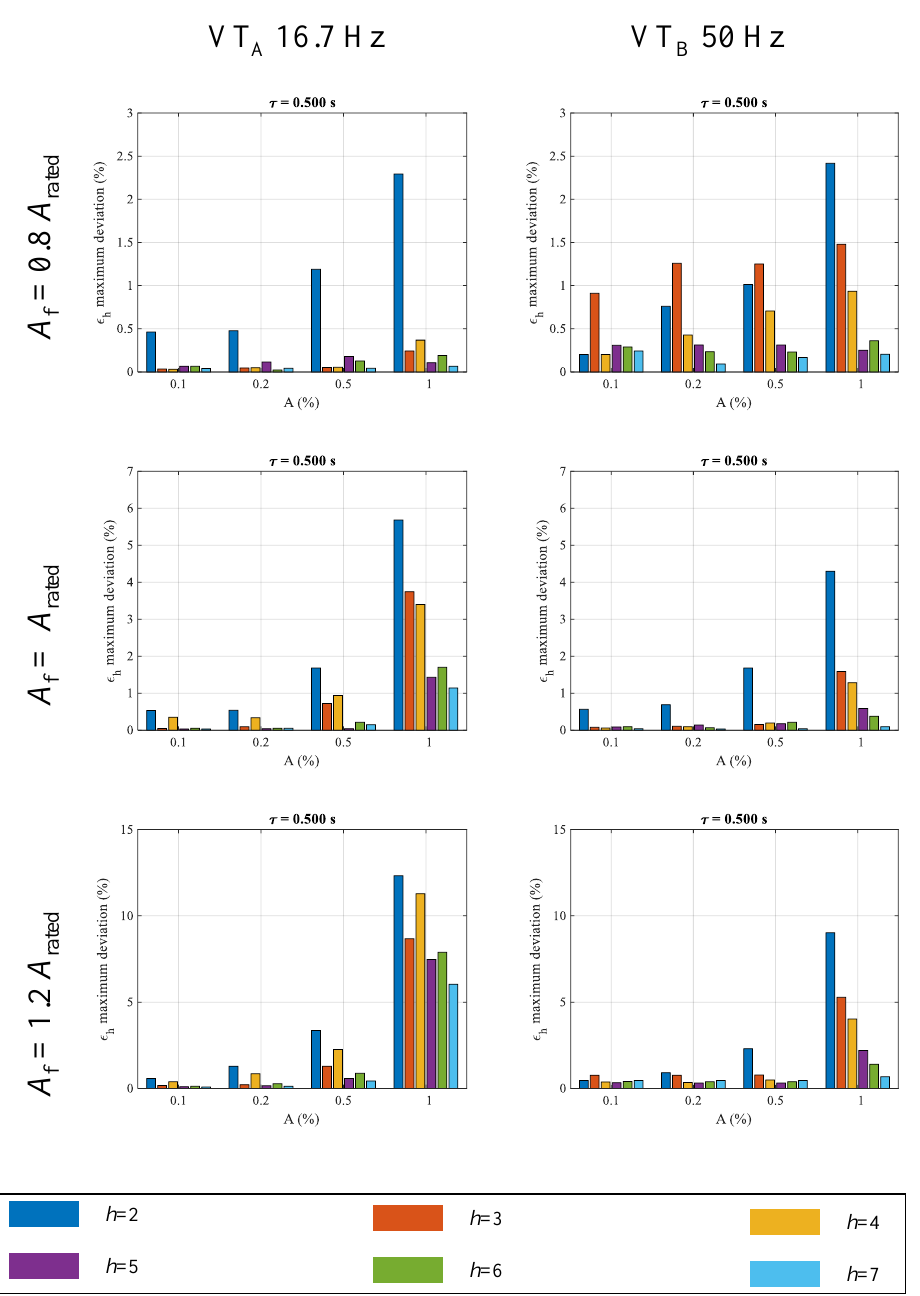
Figure 6. Comparison among the maximum error deviation from the 2nd to the 7th harmonic when the DC disturbance occurs at different fundamental